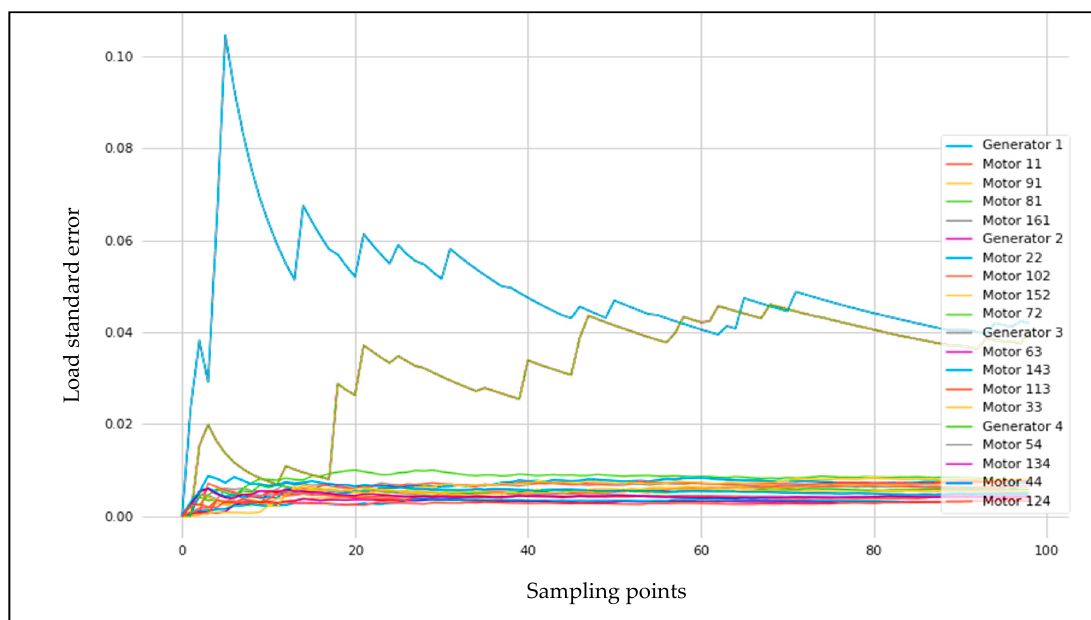
Figure 22. Monte Carlo standard deviation for the cruising case study. Figure 20. Monte Carlo standard deviation for the RTO study. Figure 24. Monte Carlo standard deviation for the cruising case study.